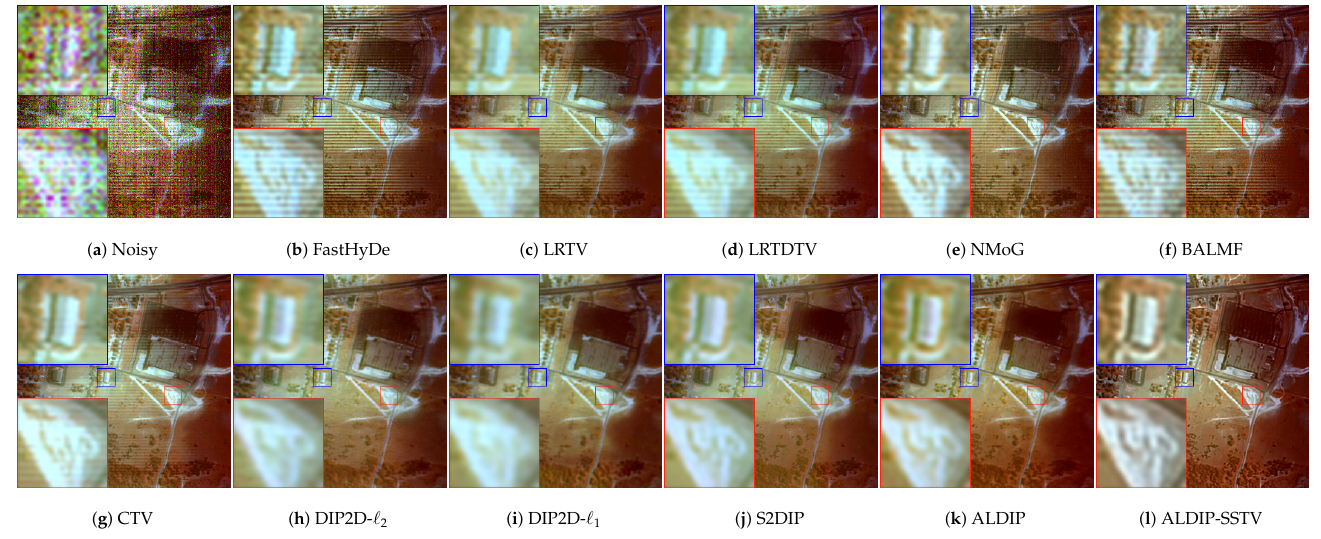
Figure 10. Noisy and denoising result by methods for comparison on real-world noisy HSI Urban dataset. The pseudo images consisted of the 104th, 108th and 109th bands are displayed. Two local areas (red and blue squares) are demarcated zoomed for easy observation.